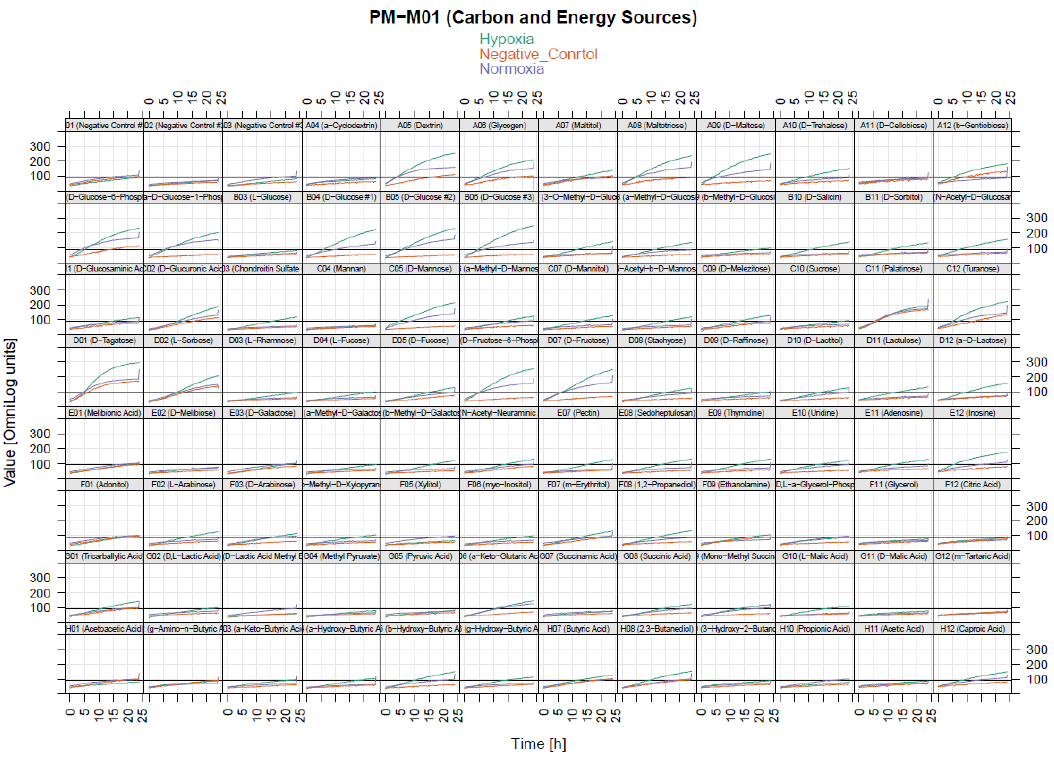
Figure 4. Metabolic fingerprint of phenotype microarray in MDA-MB-231 cell line. Graphical depiction of PM-M1 plate from (0–24) h in OmniLog reader; 96-well plate representation in each plate. Each well represents three groups: hypoxia, normoxia (control), and negative control (without cells). Shown is time on x axis versus OmniLog value on y axis. PM-M1 plate shows that hypoxic cell group utilized many substrates as energy, as indicated in green line.